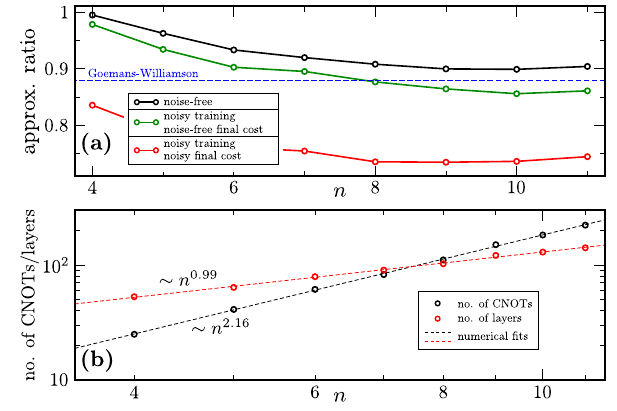
Fig. 4 QAOA heuristics in the presence of realistic hardware noise: increasing problem size for a fi xed number of rounds. The approximation ratio averaged over 60 random graphs of increasing number of nodes n and fi xed number of rounds p = 4 is plotted. The black, green, and red curves respectively correspond to noise-free training, noisy training with noise-free fi nal cost evaluation, and noisy training with noisy fi nal cost evaluation. a For a problem size of 8 nodes or larger, the noisily-trained approximation ratio falls below the performance guarantee of the classical Goemans- Williamson algorithm. b The depth of the circuit (red curve) scales linearly with the number of qubits, con fi rming we are in a regime where we would expect to observe Noise-Induced Barren